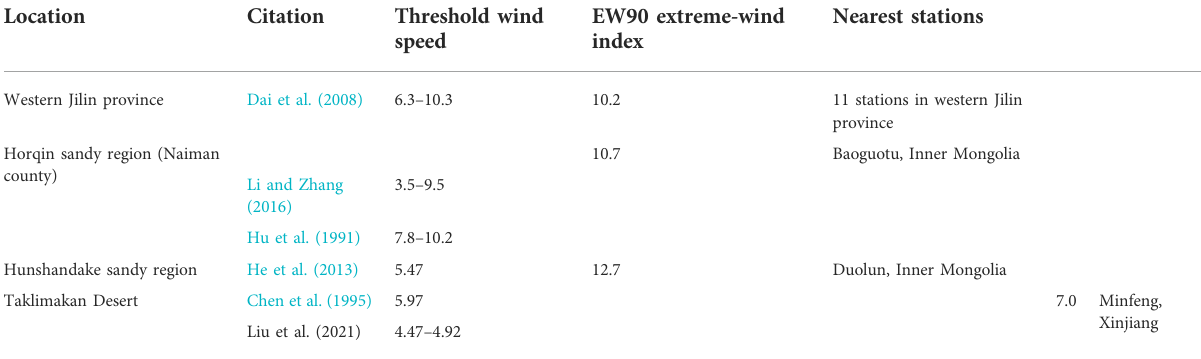
TABLE 3 Threshold wind speed of dust emission (m s − 1 ) in existing studies, and EW90 extreme-wind indices in the nearest meteorological